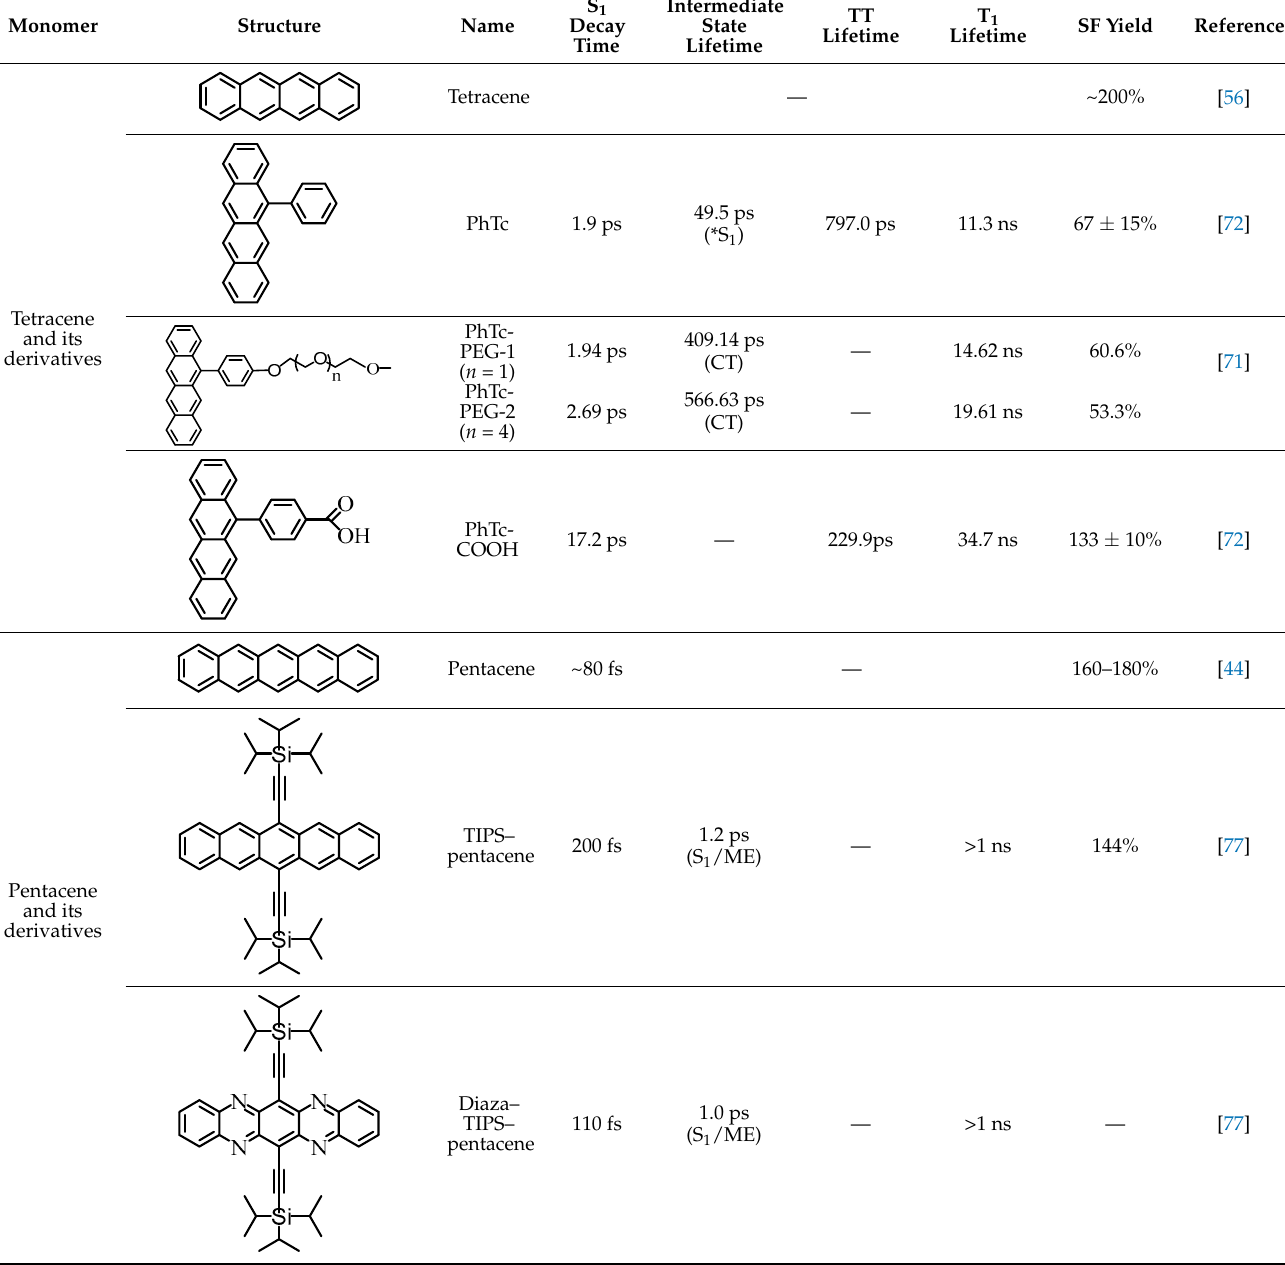
Table 1. Summary of time scales of the SF process in monomers.